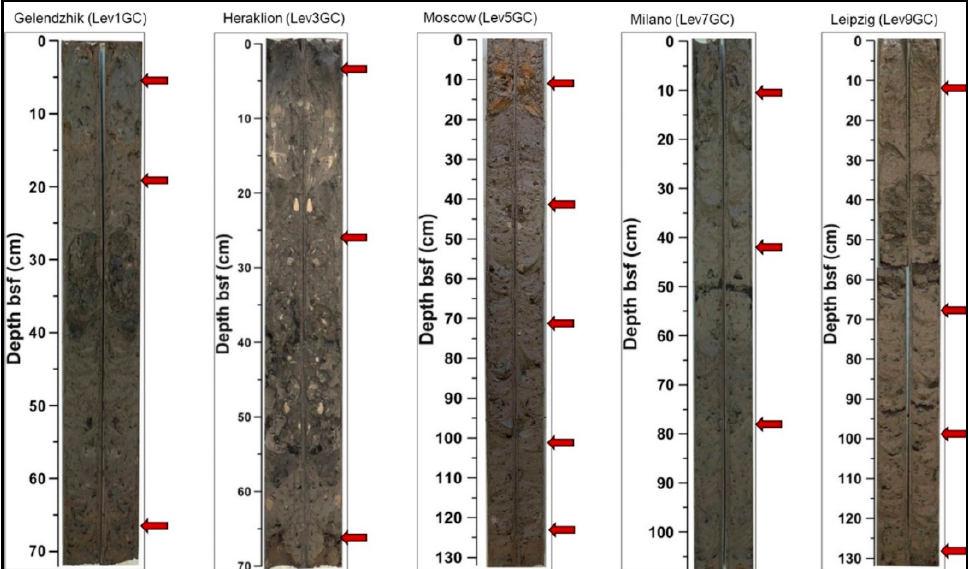
Figure 3. Images of the gravity cores recovered from the five MVs, showing the coring depth below seafloor (bsf) and the various mud breccia facies. The red arrows indicate the sampling core intervals. Modified from Panagiotopoulos et al. [26]. For a detailed description of the cored sediments see Panagiotopoulos et al. [26].